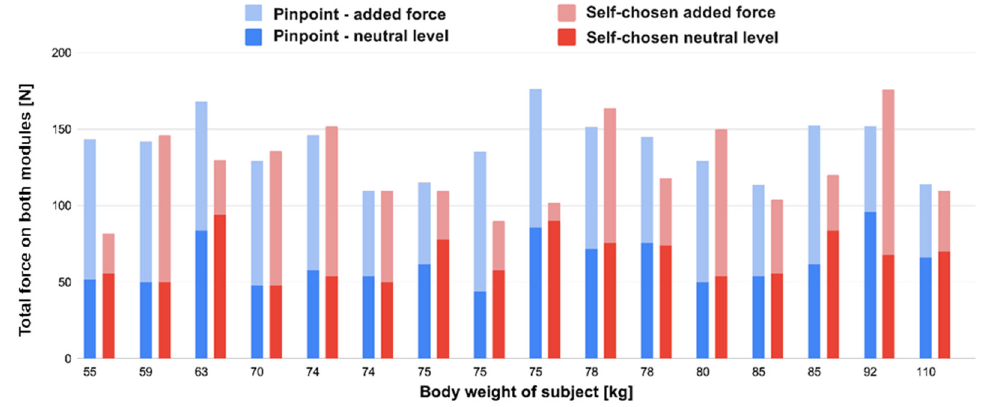
Figure 11. Forces in the chair at the most comfortable moment, per subject, sorted by weight.